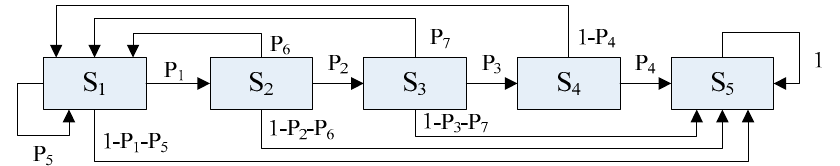
Figure 1. Prediction model of remanufacturing systems return based on Markov method.